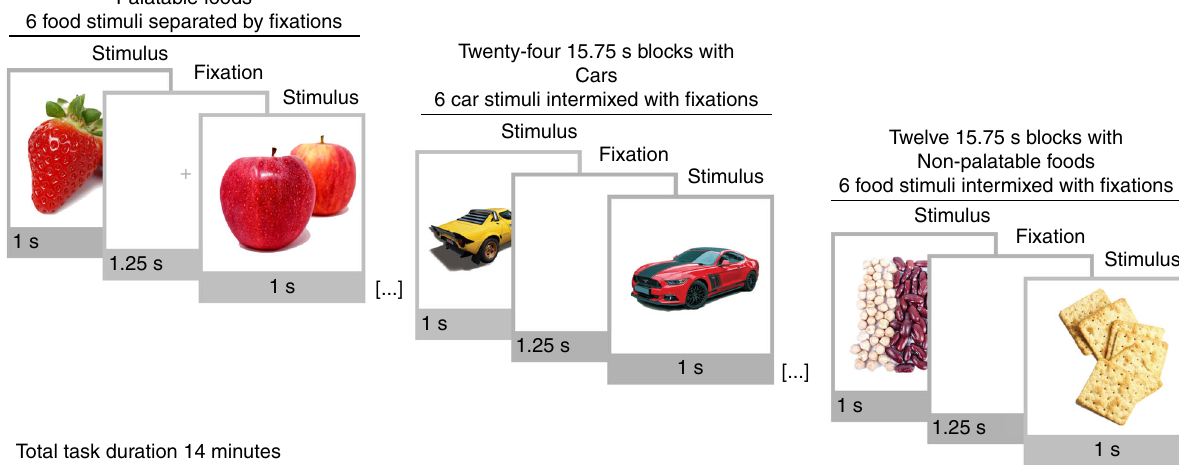
Fig. 1 Experimental design for fMRI. Subjects viewed alternating 15.75-s epochs with palatable foods, non-palatable foods or cars. Each block contained six stimuli from one category, intermixed with fi xation